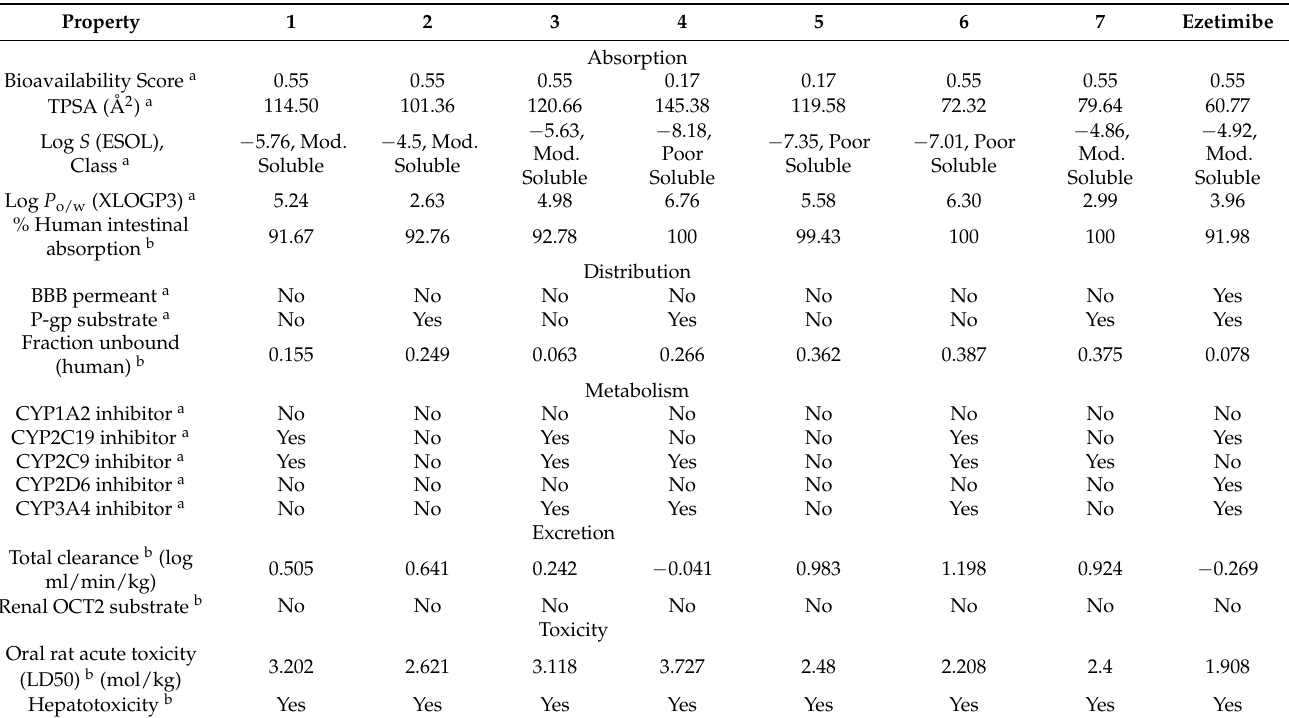
Table 5. Predicted ADME/Tox properties of compounds 1–7 and